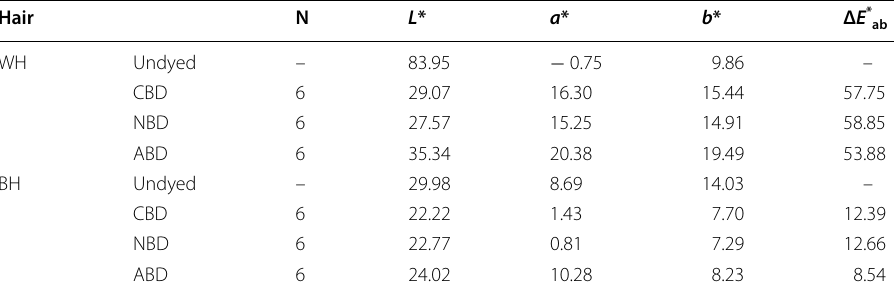
Table 6 Color values of white hair (WH) and bleached hair (BH) dyed with three types of basic hair